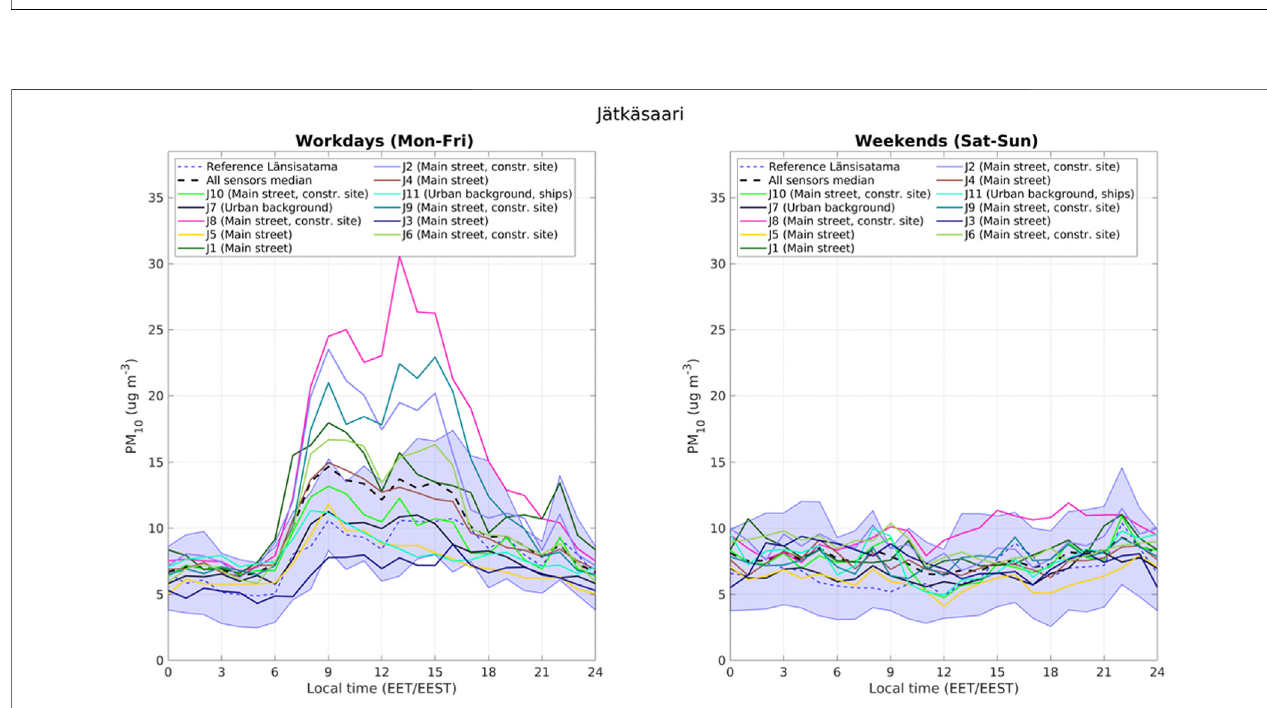
FIGURE 11 | Median diurnal cycles of PM10 mass concentration during 4-month period (1.7.-31.10.2020) for sensors located in Jätkäsaari (left) workdays (Mon- Fri) and (right) weekends (Sat-Sun). Reference measurements show median (dashed line) and 25th and 75th percentiles (shaded area) from nearest reference instrument. Black dashed line shows median diurnal cycle calculated for all data from that location.